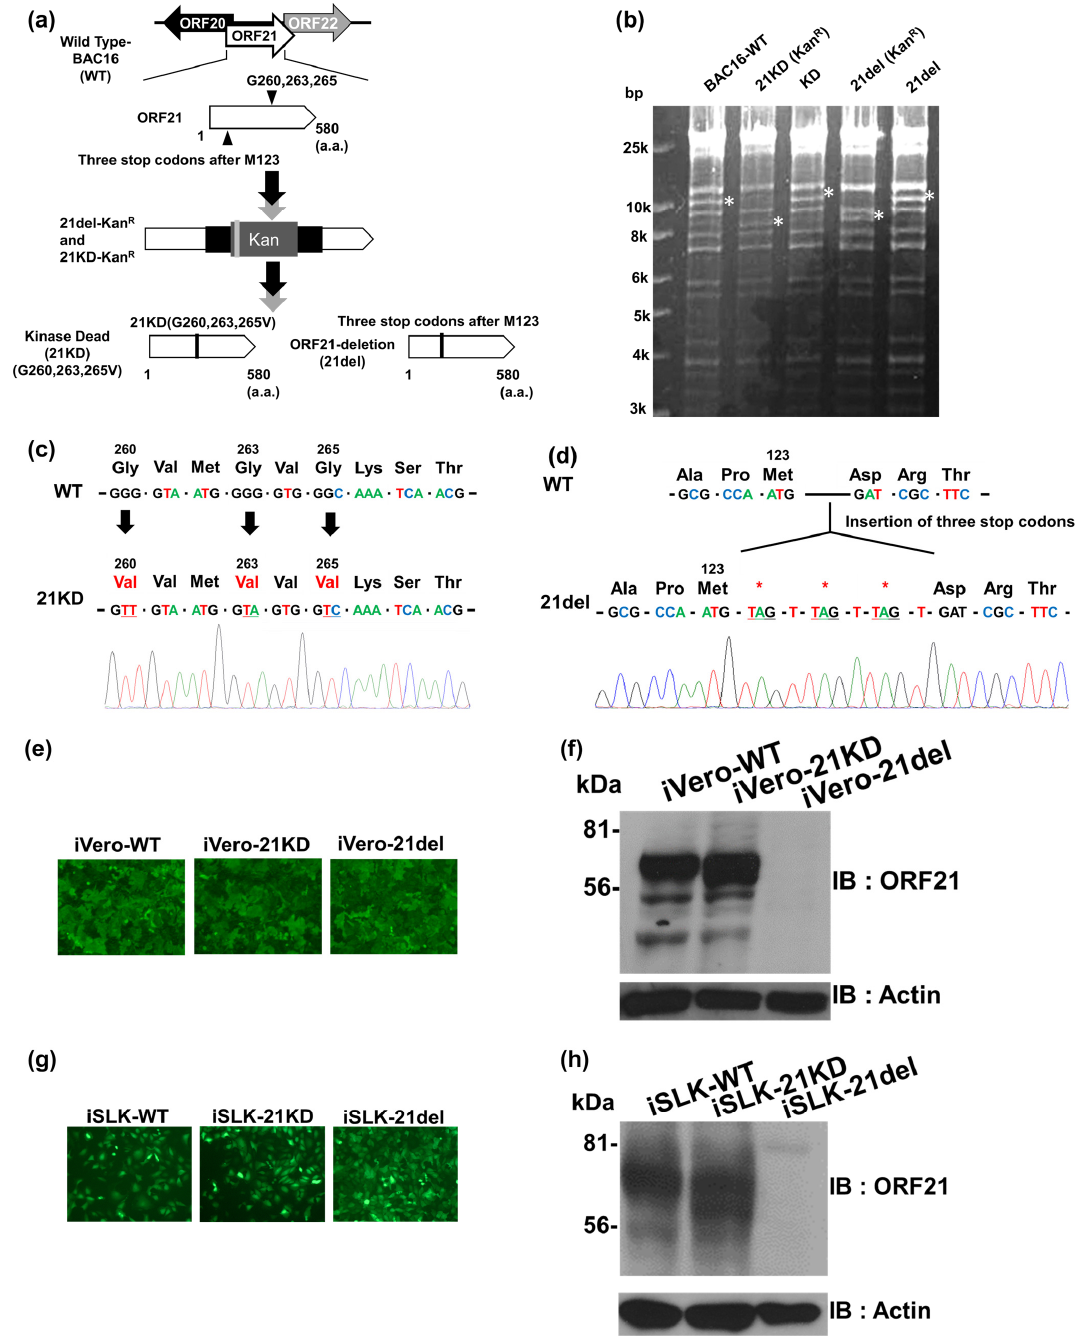
Figure 1. Construction of ORF21-kinase dead (21KD) and ORF21-deleted (21del) KSHV BAC16. ( a ) Schematic diagrams of the KSHV genome, including the ORF21-coding region. Two types of mutations (i.e., ORF21-kinase dead and ORF21-deleted) were generated in the ORF21 coding region (nucleotides (nt)35202 to nt36943) of the wildtype (WT) KSHV BAC16 clone (WT-BAC16) (GenBank accession number: GQ994935) by a two-step red recombination method. ORF21-kinase dead BAC16 (21KD-BAC16) had a kinase activity deficient mutation through the substitution of three Gly residues (G260, G263, and G265) within the ORF21 coding region in WT-BAC16. ORF21-deleted BAC16 (21del- BAC16) had a three stop codons insertion located after the fourth Met123-codon within the ORF21 coding region in WT-BAC16. a.a., amino acids. ( b ) Agarose gel electrophoresis of mutated BAC16 clones digested with Hind III. The asterisks indicate the insertion and deletion of the